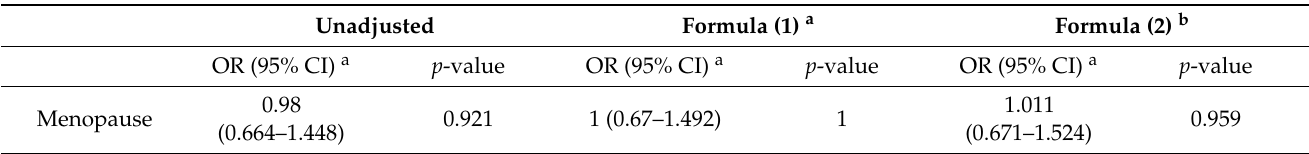
Table 3. Odds ratios for risk of age-related macular degeneration according to menopause after matching. Korea National Health Insurance Database,